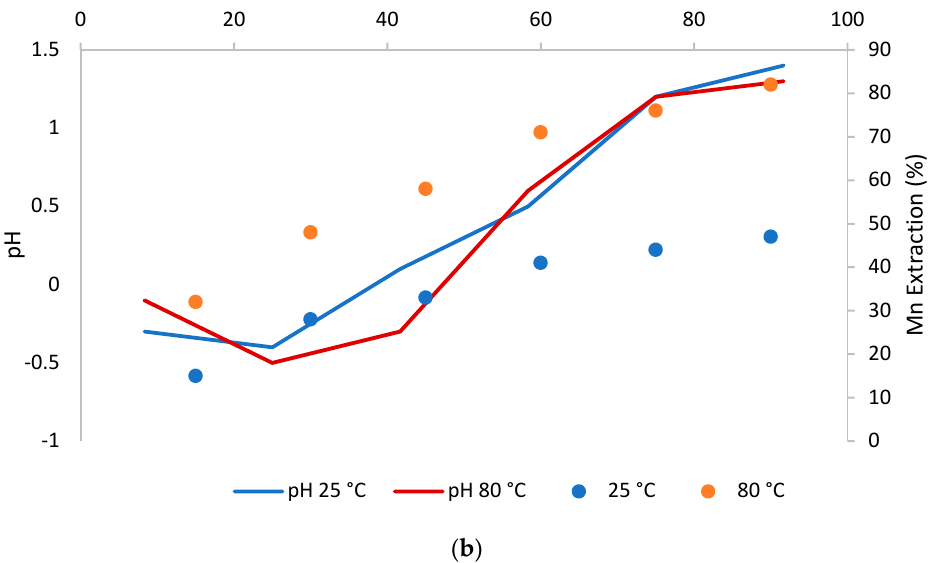
Figure 4. Dissolution of Fe and Mn over time from CuFeS2 at room temperature (25 °C) and high temperature (80 °C) ( a ): dissolution of Fe and its behavior at changes in pH; ( b ): dissolution of Mn and its behavior at changes in pH).